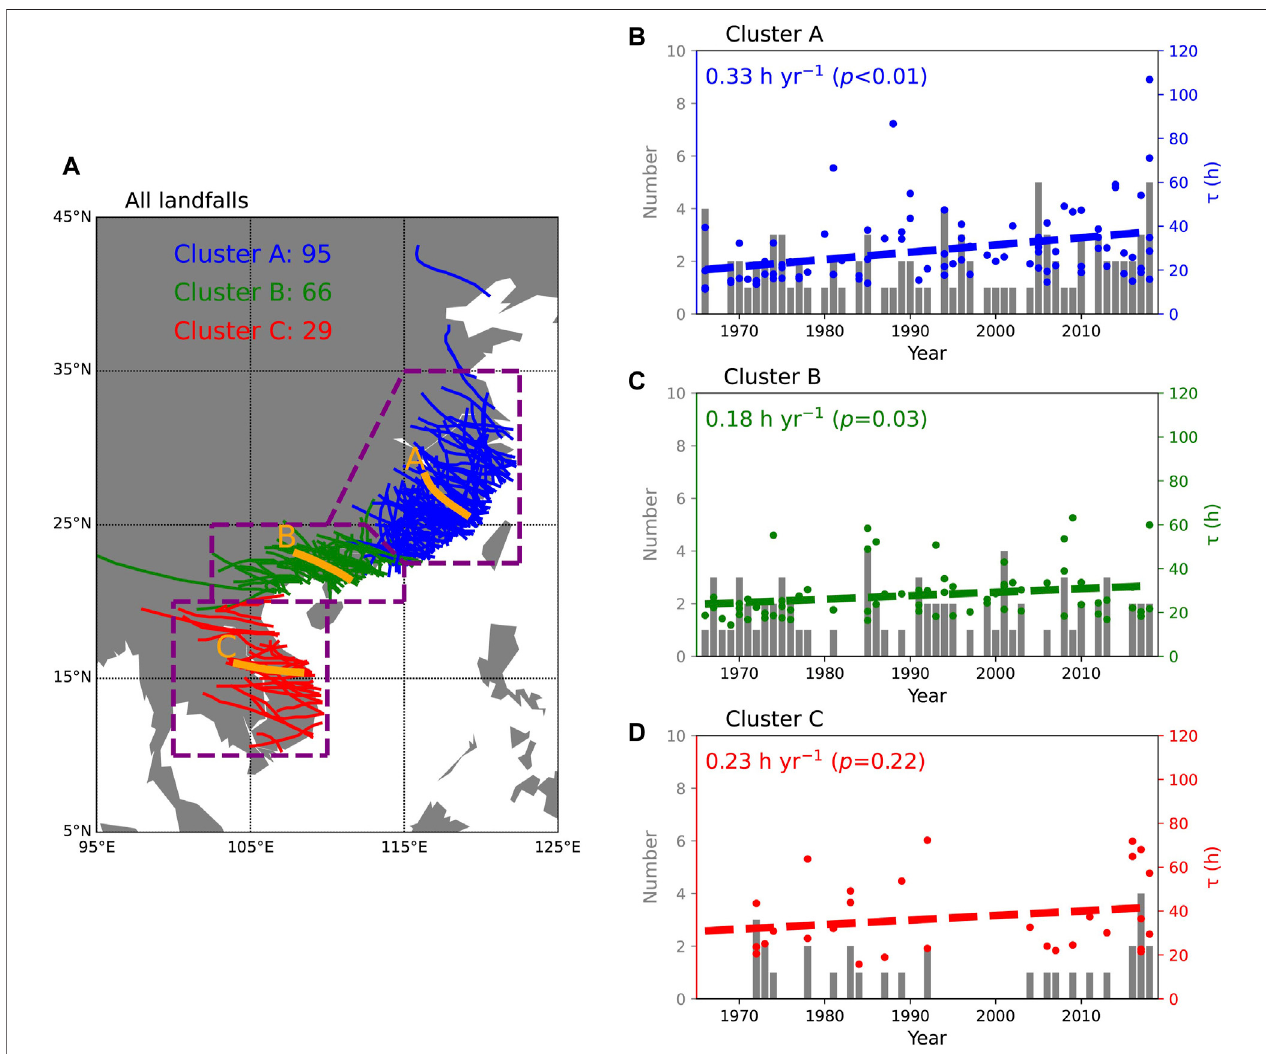
FIGURE3|(A) Tracks of190WNP TClandfallsidenti fi edfromtheCMAdatasetfrom 1966to2018. Thetrajectoriesduringthe fi rst24 h afterlandfallinClustersA, B, C are represented as blue, green and red thick lines, respectively. The mean trajectories for the three clusters are shown by thick orange lines. The main occurrence regionforlandfallsinthe threeclustersarebounded bypurple dashed lines (b ∼ d)Time series oftheannual number (graybars) andthe decaytimescale τ (points)for (B) ClusterAlandfalls, (C) ClusterBlandfallsand (D) ClusterClandfallsfortheperiodfrom1966 – 2018.Thedashedlinesdenotethelong-termtrendsobtainedbyleast squares, while their corresponding slopes and signi fi cance levels are given in the panels.